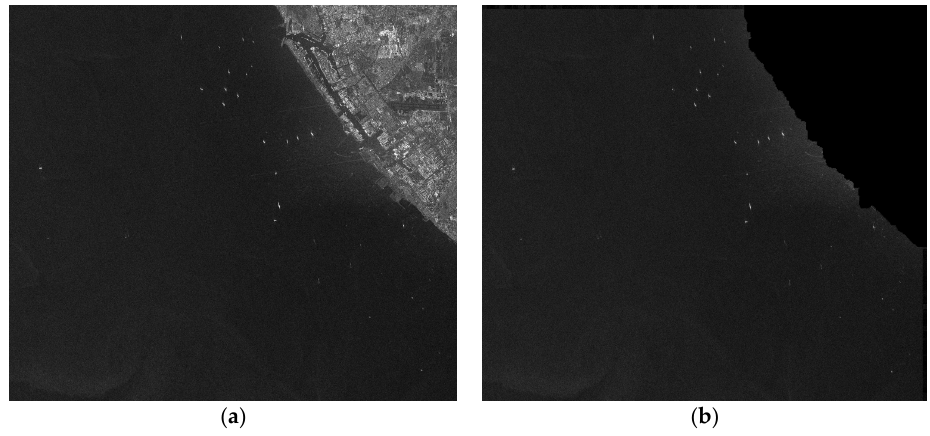
Figure 11. Land masking results of RADARSAT-1 ROI, ( a ) The image after cutting; and ( b ) The image after land removed.